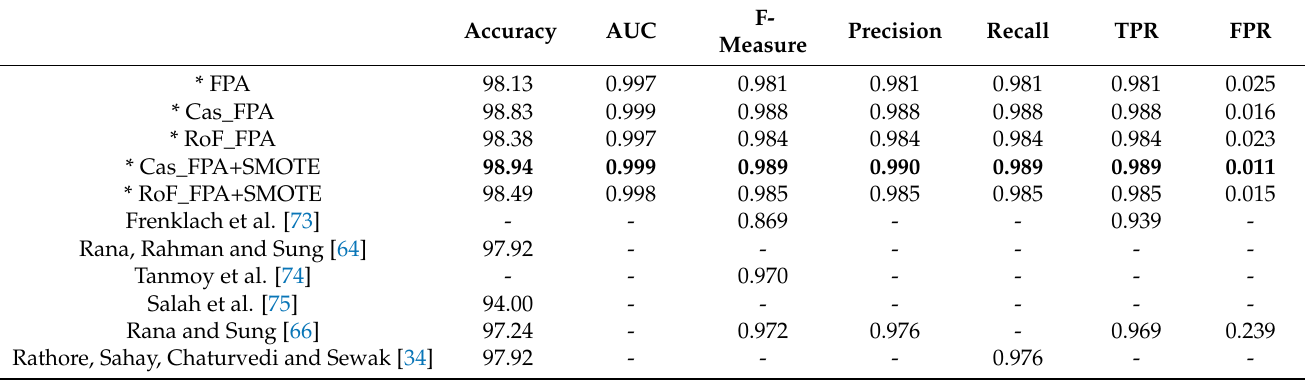
Table 15. Detection performances of proposed methods and existing models on the Drebin dataset. F- Precision Recall TPR Accuracy AUC Measure